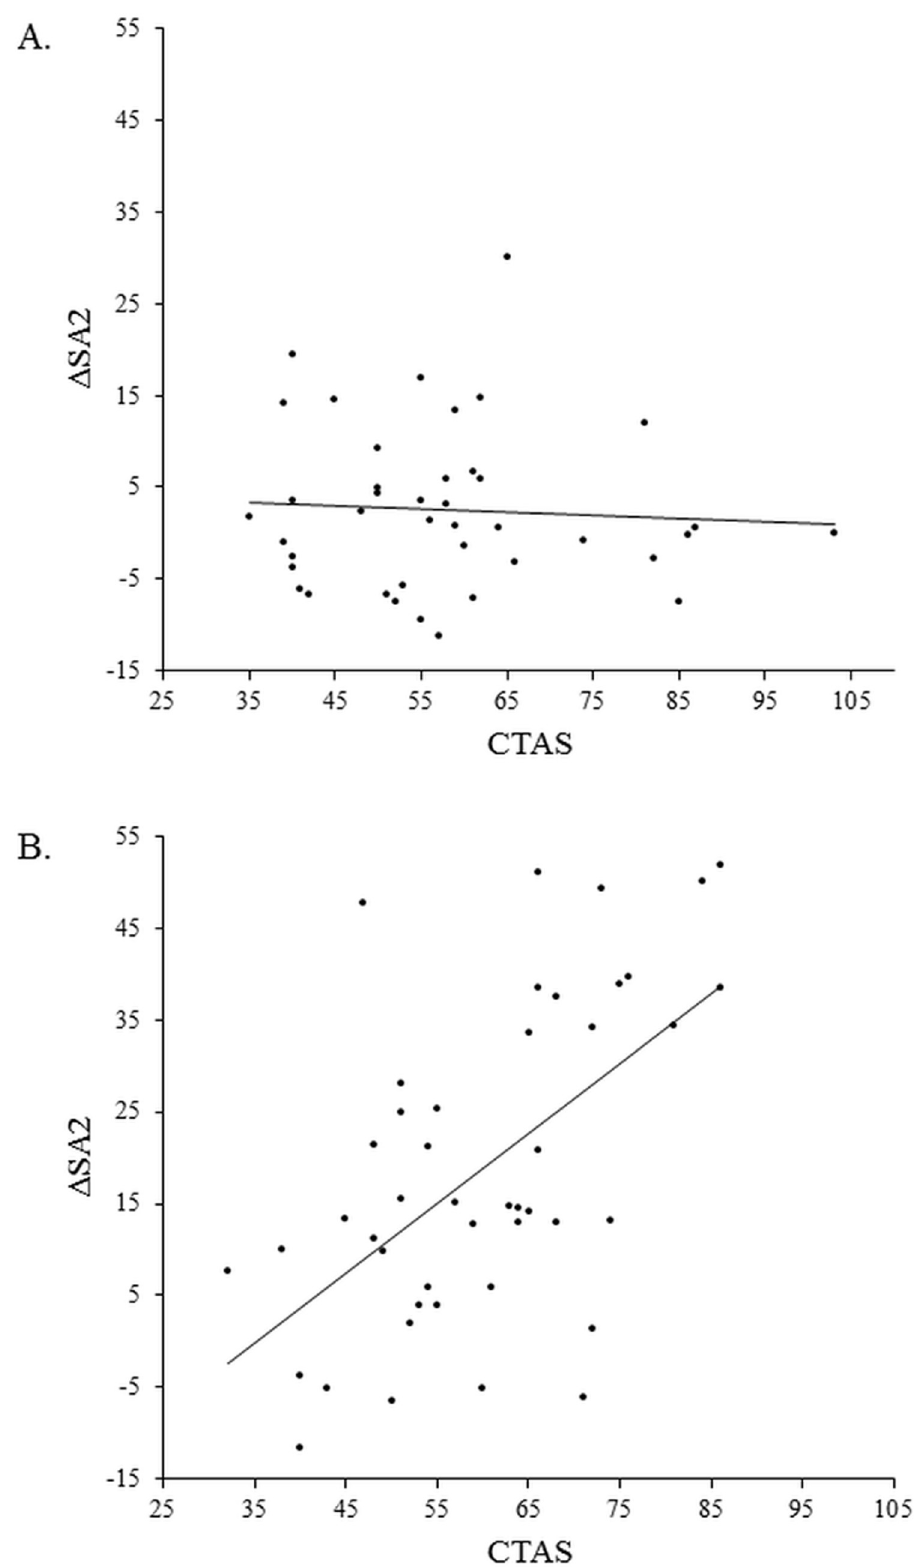
Fig 3. Scatterplots for the relationships between CTAS and Δ SA 2 (SA at t 2 minus t 1 ) in the control (panel a; r = -.06, p = .711) and the stress group (panel b; r = .57, p < .001).